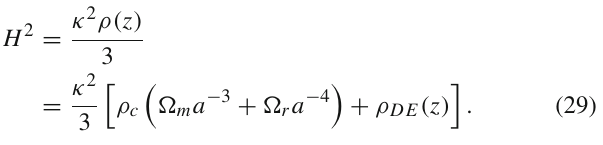
figure, we choose the same primordial matter density fluc- tuation for the Starobinsky and exponential models as